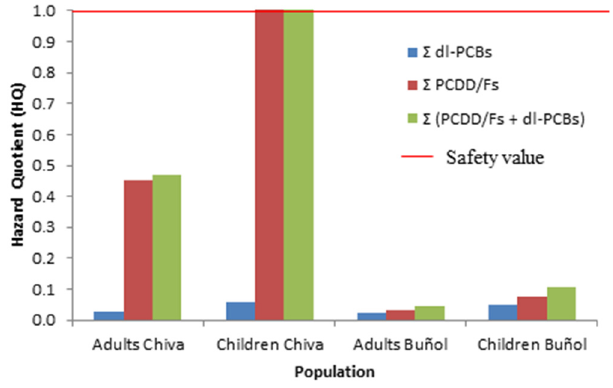
Figure 3. Hazard quotient at Chiva and Buñol stations for adults and children.